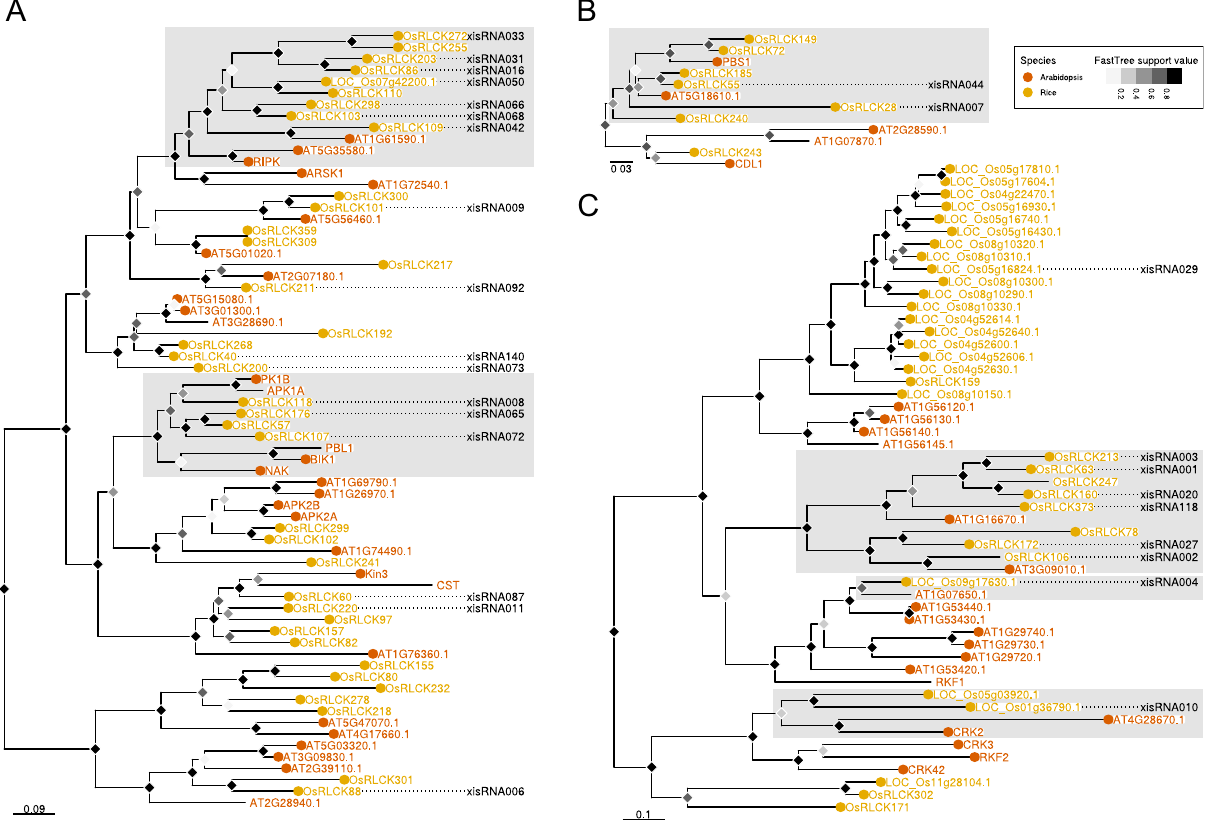
Figure 4. Multiple xisRNA loci cis -gene products with kinase domains are related to immune signaling pathways components in rice or Arabidopsis. The displayed phylogenetic trees correspond to selected sub-clades of proteins belonging to the RLCK-VIIa-2 ( A ), RLCK-VIIa-1 ( B ) and DLSV ( C ) subfamilies in the genome- wide phylogenetic tree (Supplementary File S1) constructed using the kinase domain of annotated proteins in the Arabidopsis Col-0 and Rice Nipponbare genomes. Dotted lines connect plant protein names with xisRNA identifiers when the xisRNA duplex loci is fully included in an exon of the underlying gene. Shaded rectangles highlight clades that are discussed in the text. The FastTree support value grey scale for tree nodes corresponds to local bootstrappings used by FastTree to estimate the tree’s reliability. Scale bars correspond to substitutions per